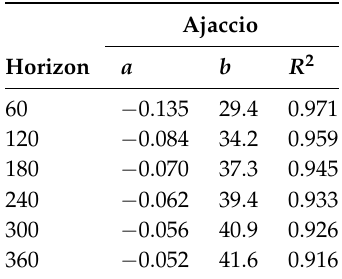
Figure 14. Error (nRMSE) vs. time-step ( ∆ t ) for tilted irradiance (45 ◦ ) in Ajaccio. Table 4. Fitting results for Tilted Irradiance (45 ◦ ) in